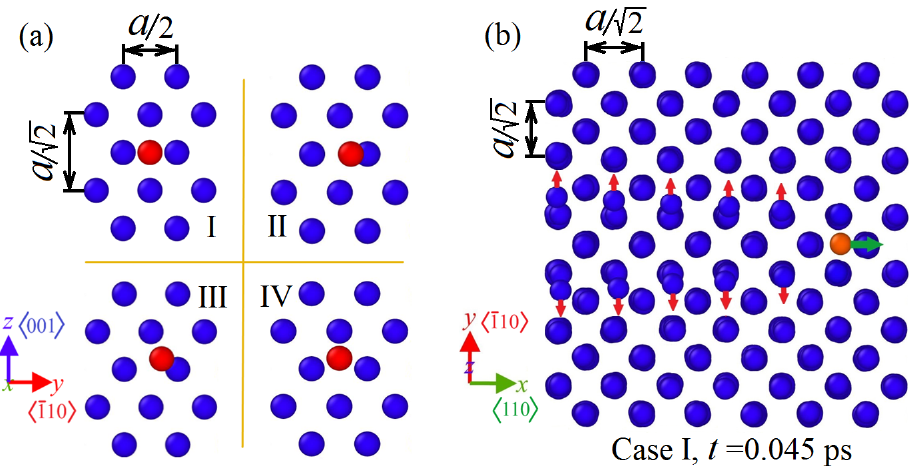
Figure 1. ( a ) Schematic illustration of the four considered entry points of the bombarding atom (highlighted in red) into the crystal. The x , y , and z axes are directed along the crystallographic directions (cid:104) 110 (cid:105) , (cid:104) ¯110 (cid:105) , and (cid:104) 001 (cid:105) , respectively. ( b ) The snapshot demonstrating motion of the bombarding atom in the octahedral pore channel along the x -direction. The velocity vector of the moving atom is shown by the green arrow. The atoms behind the moving bombarding atom obtain momentum in the direction perpendicular to the velocity vector of the bombarding atom (shown by the red arrows). A snapshot of the structure at time t = 0.045 ps for case I is